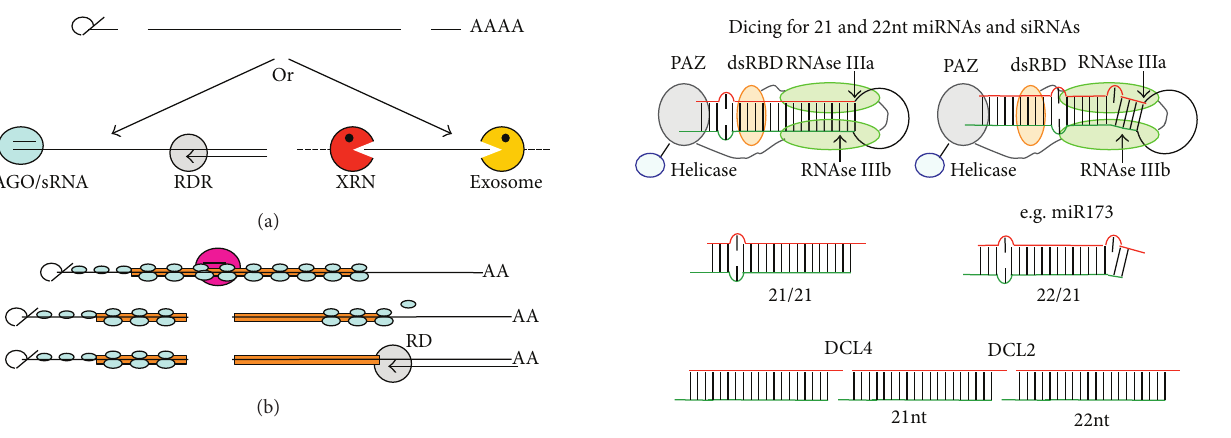
F6:Productionof22ntsRNAs.22ntmiRNAscanbeproduced from asymmetrically bulged miR-precursors; 22nt siRNAs are pro- duced from dsRNA by DCL2, while DCL4 produces 21nt